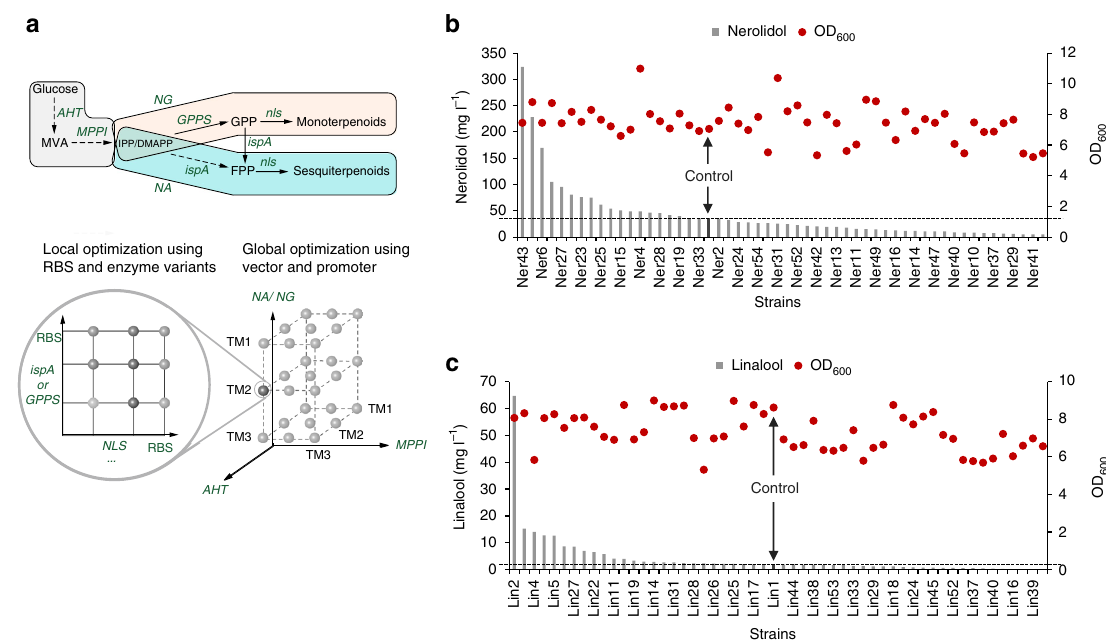
Fig. 8 MHP for the production of universal compounds. a Demonstration of design strategy of MHP. Globally, we used 3 promoters to regulate the transcription of three major modules: the upstream MVA pathway (module AHT), the downstream MVA pathway (module MPPI), the terpenoid pathway (module NG including nls and GPPS or module NA including nls and ispA ). Locally, we used 3 RBSs to control the relative translation of nls and GPPS (or ispA ). In total, there were 3 5 or 243 combinations. b Nerolidol production and cell density for the chosen 54 strains including one control (Ner1, highlighted by an arrow). c Linalool production and cell density for the chosen 54 strains including one control (Lin1, highlighted by an arrow). Nls ,